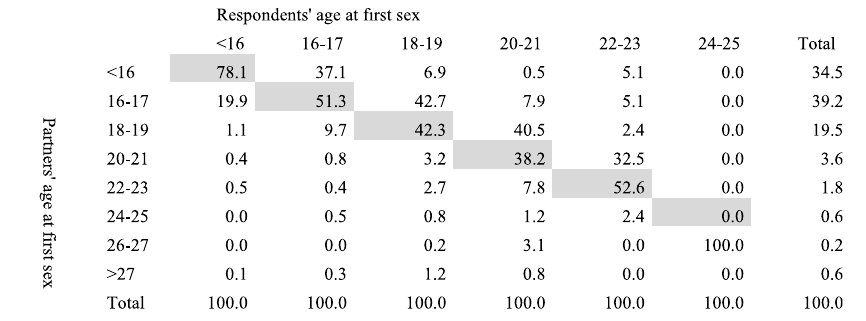
Table 3 Age matrices at first sexual intercourse of male survey respondents and their female partners, 2017 SELFY wave